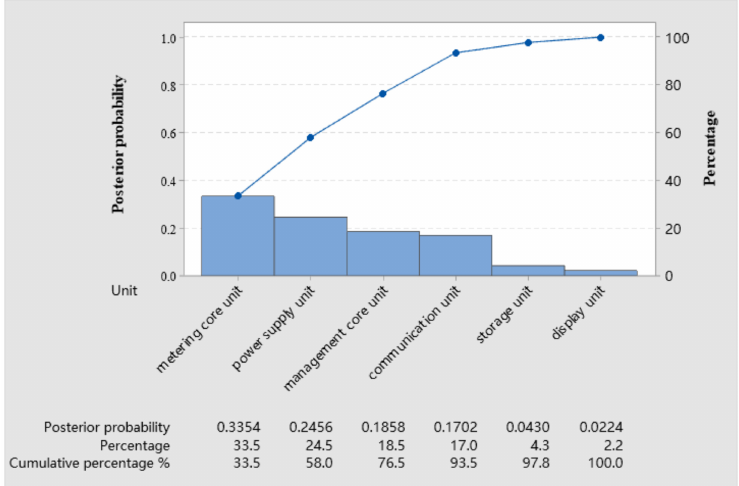
Figure 14. Posterior probability permutation chart of each